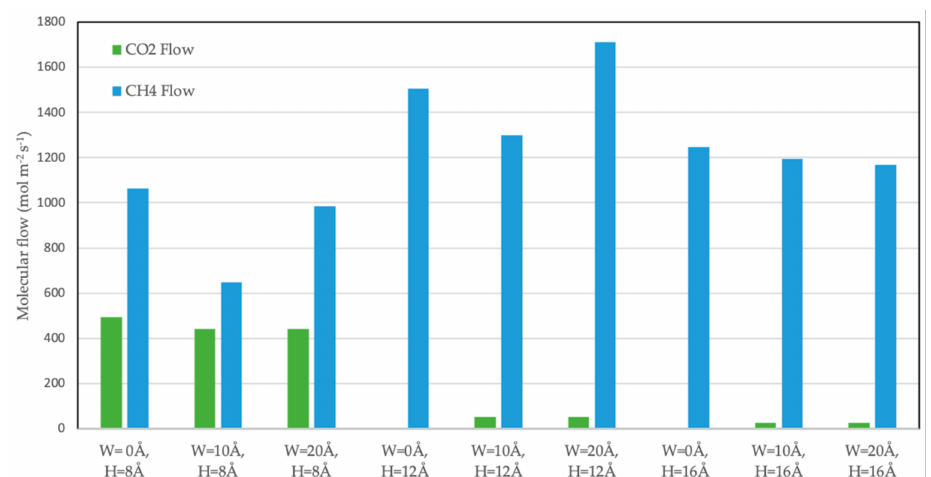
Figure 3. Molecular flow of CO 2 and CH 4 gases passing through two-stage bilayer NPG membranes for configurations with different pore offset distances (W), and interlayer spacings